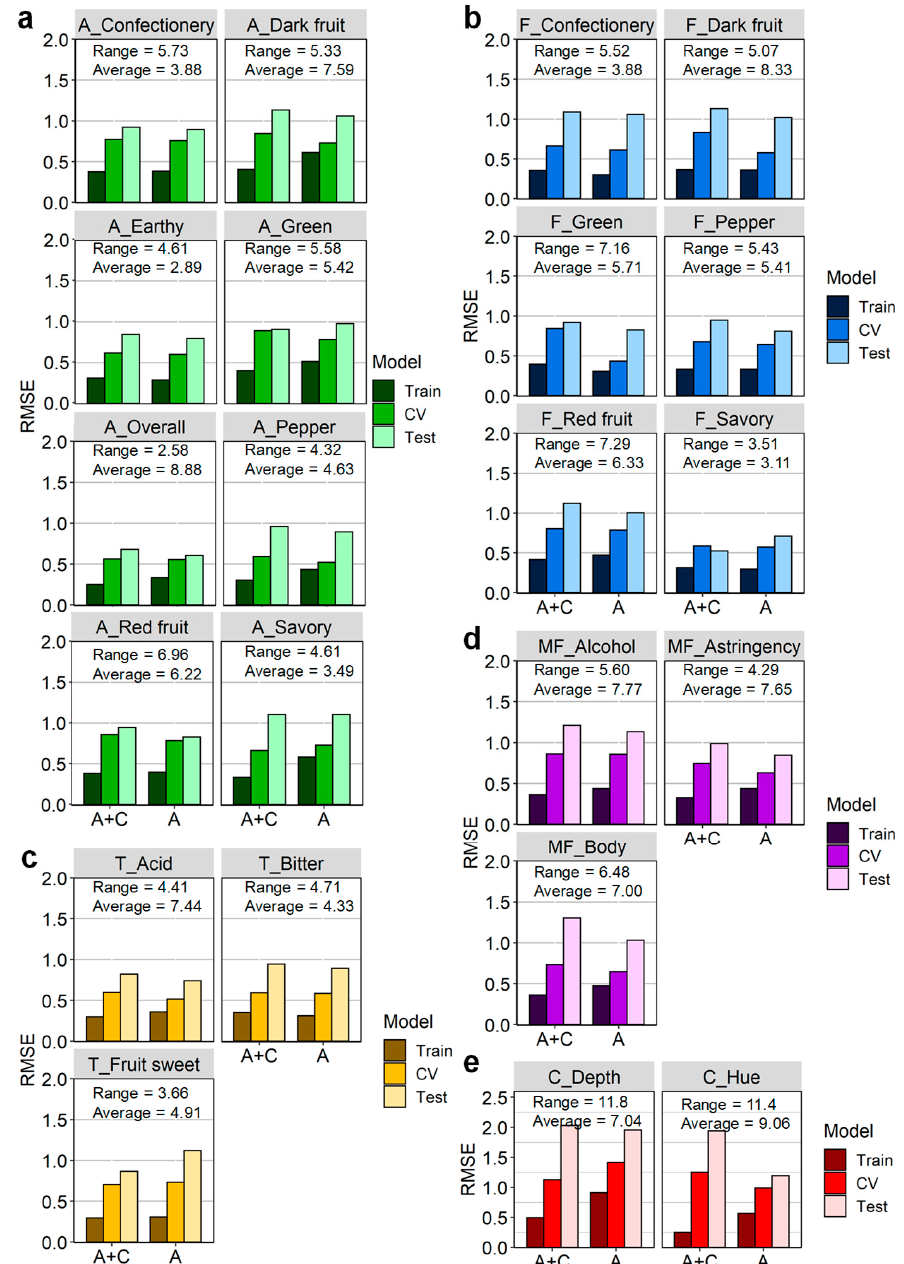
Figure 4. Bar charts of root mean square error (RMSE) values for XGBoost Train (calibration), cross-validation (CV), and Test (externally validated) models using feature-level (A + C, A-TEEM and CIELAB datasets) and variable-level (A, A-TEEM only) data fusion methods from analysis of grape extracts for the prediction of wine attribute scores related to ( a ) aroma, ( b ) flavour, ( c ) taste, ( d ) mouthfeel, and ( e ) colour. Range and average score values for Test datasets are displayed for each wine sensory attribute.